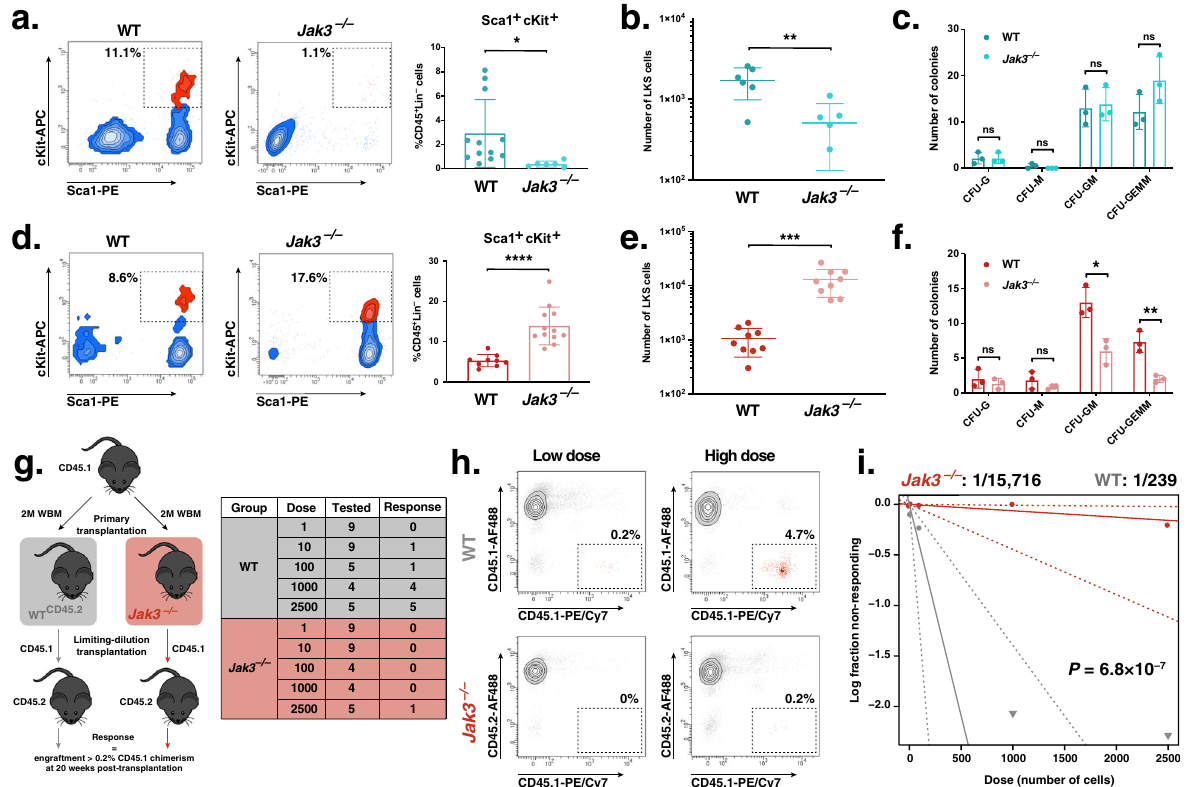
Fig. 4 Loss of Jak3 results in a hematopoietic defect in vitro and in vivo. a Representative fl ow cytometry plots depicting endpoint Lineage – cKit + Sca1 + cell expansion on wild-type (WT; dark blue) or Jak3 – / – (light blue) murine lung endothelial cells (ECs). Plotted events were gated on CD45.1 + Lineage – single live cells (left and center; n = 6). LKS cell percentages were averaged (right). b Total number of LKS cells following expansion on lung ECs as gated on DAPI – CD45.1 + Lineage – live single cells ( n = 6). Center lines represent the average number of cells. c Quanti fi cation of colony-forming unit (CFU) assays measuring the CFU-granulocytic (CFU-G), CFU-monocytic (CFU-M), CFU-granulocytic/monocytic (CFU-GM), and CFU granulocytic/erythrocytic/ macrophagic/megakaryocytic (CFU-GEMM) potentials of LKS cells following expansion onto murine lung WT (dark blue) or Jak3 – / – (light blue) ECs ( n =